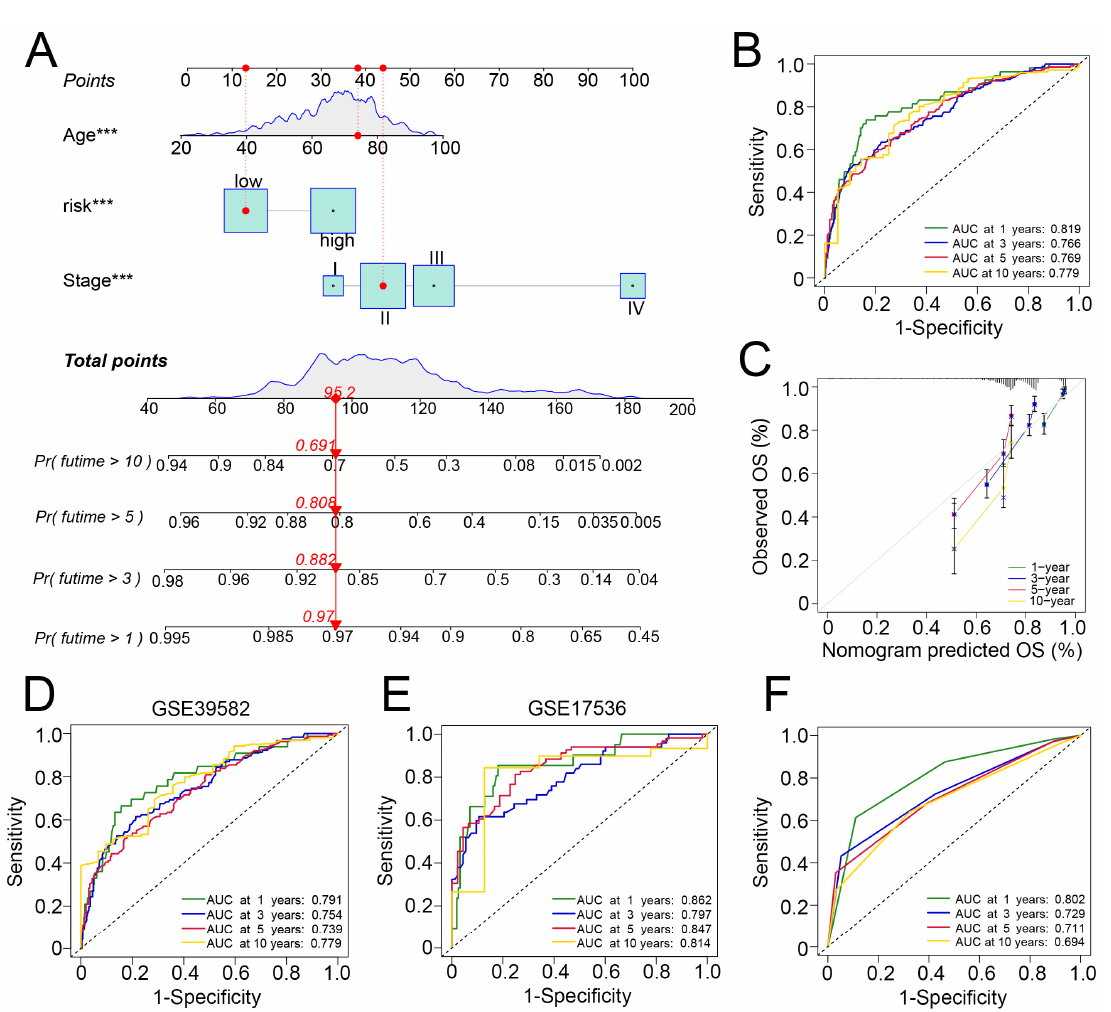
Figure 7. Development and validation of a nomogram. ( A ) Nomogram for the 1-, 3-, 5-, and 10- year survival prediction in CRC, *** indicate p < 0.001 in the univariate Cox proportional hazards regression analysis. ( B ) Time-dependent ROC curve of the nomogram for 1-, 3-, 5-, and 10-year survival prediction in the overall GEO patients with CRC. ( C ) Calibration plot for internal validation of the nomogram in the overall GEO patients with CRC. ( D , E ) ROC curve of the nomogram for 1-, 3-, 5-, and 10-year survival prediction in the subgroups, GSE17536 and GSE39582. ( F ) ROC curve of the TNM stage for 1-, 3-, 5-, and 10-year overall survival